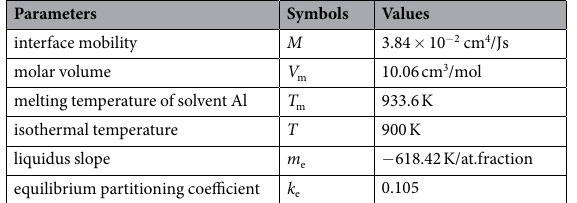
Table 1. List of all the relevant parameters used in the present calculation of nucleus